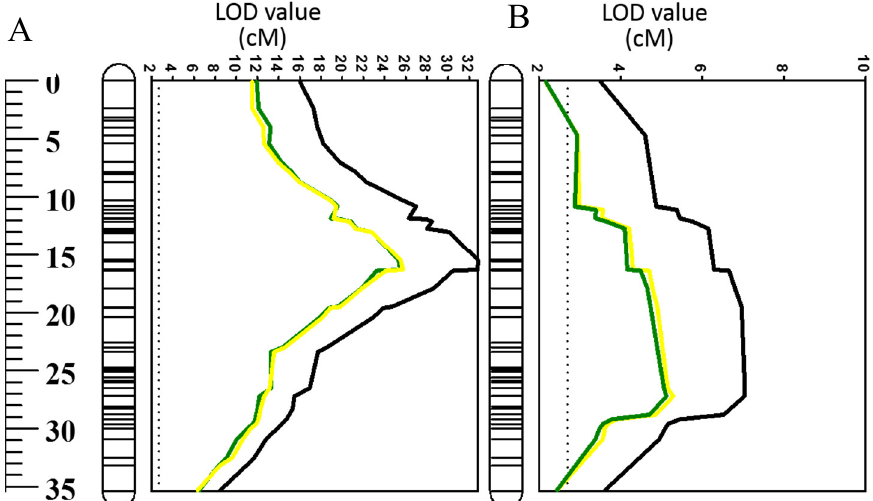
Figure 6. QTL associated with ( A ) salinity and ( B ) waterlogging tolerance (LOD values) on 2HS. Black line: LOD value of original QTL; green line: LOD value of QTL when superoxide (O 2 •− ) in the mature zone was used as a covariate; yellow line: LOD value of QTL when hydrogen peroxide (H 2 O 2 ) in elongation zone was used as a covariate.